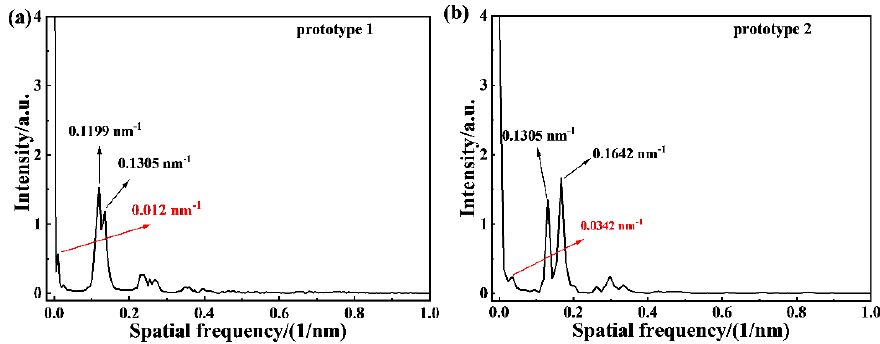
Figure 6. Spectral characteristics of the sensing structure. ( a ) Prototype 1. ( b ) Prototype 2.